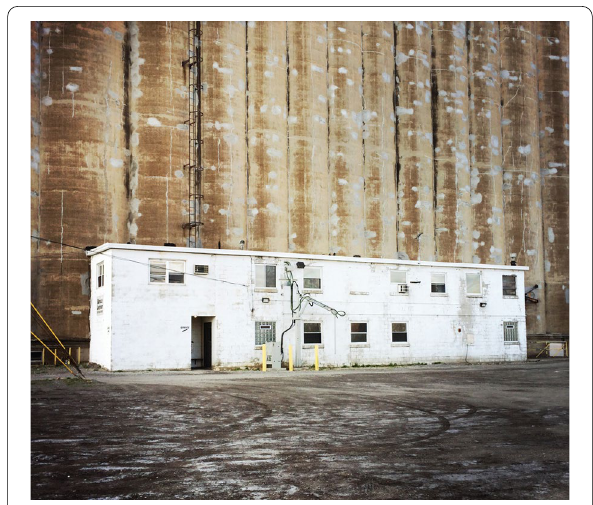
Fig. 7 Grain elevators. Silo City. Buffalo, New York (Photo by author)